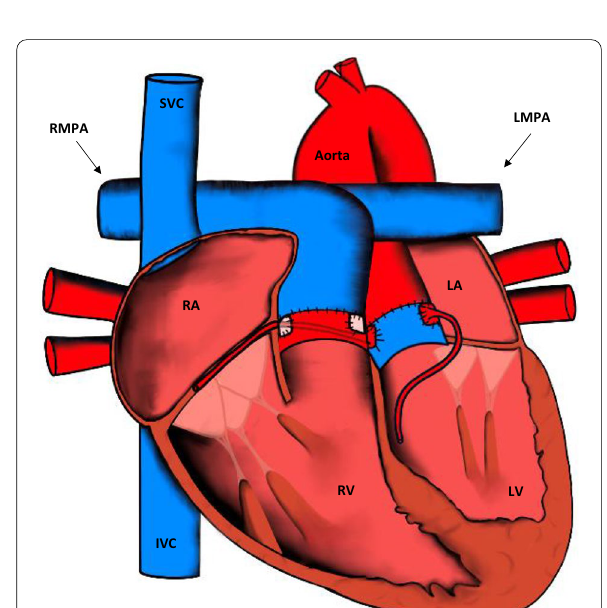
Fig. 3 Appearances of the heart after the arterial switch procedure. The aorta and the pulmonary trunk are transected near their origin and translocated along with the coronary arteries. IVC: inferior vena cava; LA: left atrium; LV: left ventricle; LMPA: left main pulmonary artery; RMPA: right main pulmonary artery; RA: right atrium; RV: right ventricle; SVC: superior vena